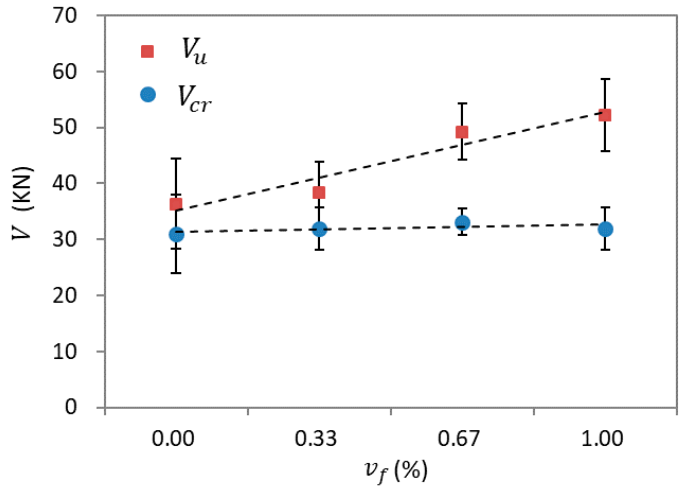
Figure 9. Cracking and ultimate loads measured from the shear tests of anchors with increasing fiber volume percentages from zero to 1.00%.